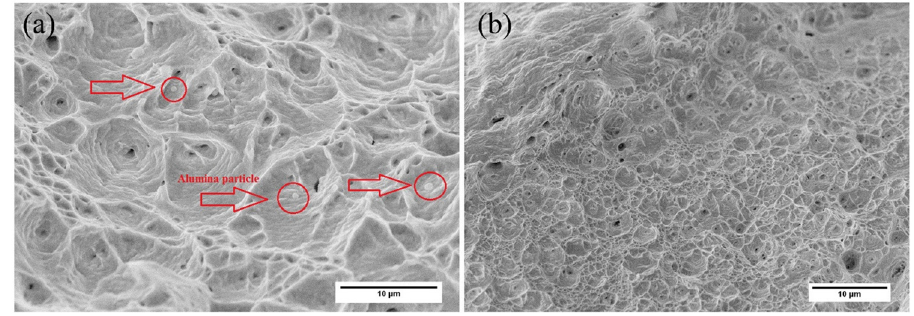
Figure 13: Rapture morphology of ( a ) monolithic and ( b ) Al/10